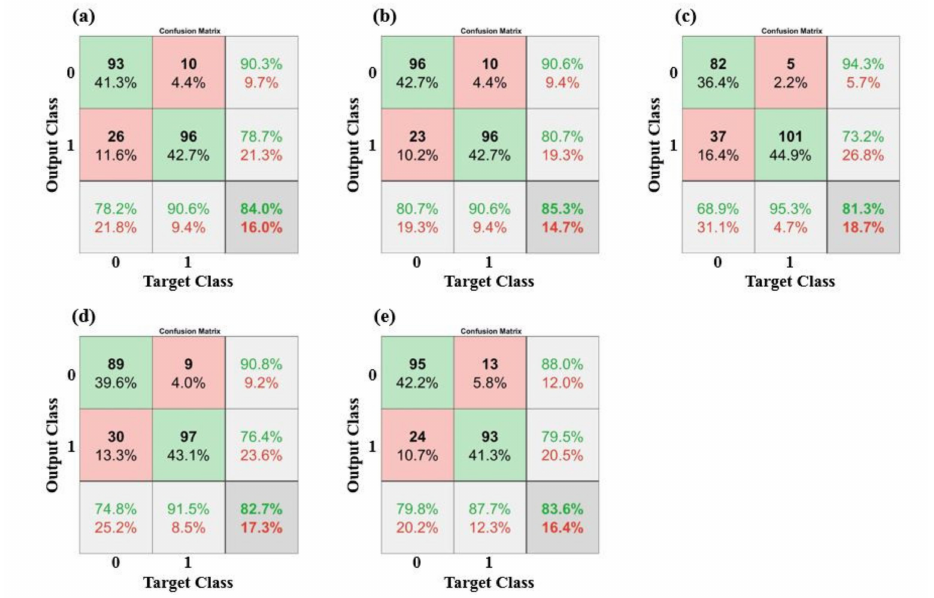
Figure 5. Confusion matrices of classifier models: ( a ) LR, ( b ) SVM, ( c ) KNN, ( d ) RF, ( e )